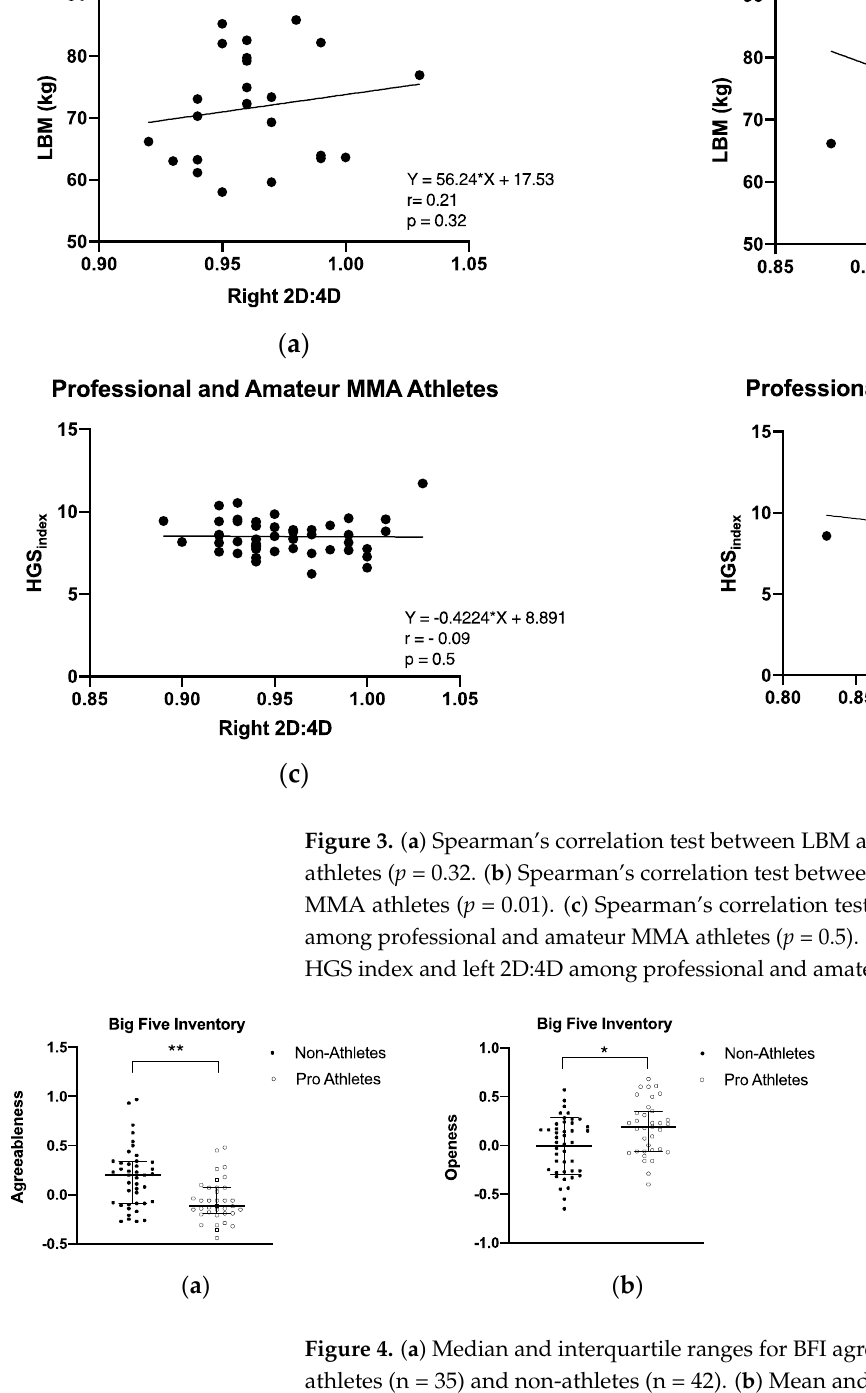
Figure 4. ( a ) Median and interquartile ranges for BFI agreeableness between groups of professional athletes (n = 35) and non-athletes (n = 42). ( b ) Mean and standard error for BFI openness between groups of professional athletes (n = 35) and non-athletes (n = 42). (c) Mean and standard error for